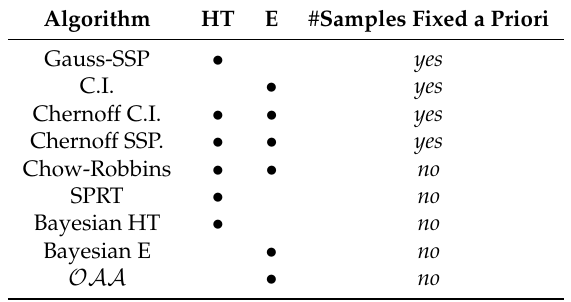
Table 1. For each considered algorithm we show with a • if it supports Hypothesis Testing (HT) and/or Estimation (E). In the last column yes means that the algorithm pre-computes the number of samples (#Samples Fixed a Priori), whereas no means that the number of samples is computed at runtime. Algorithm HT